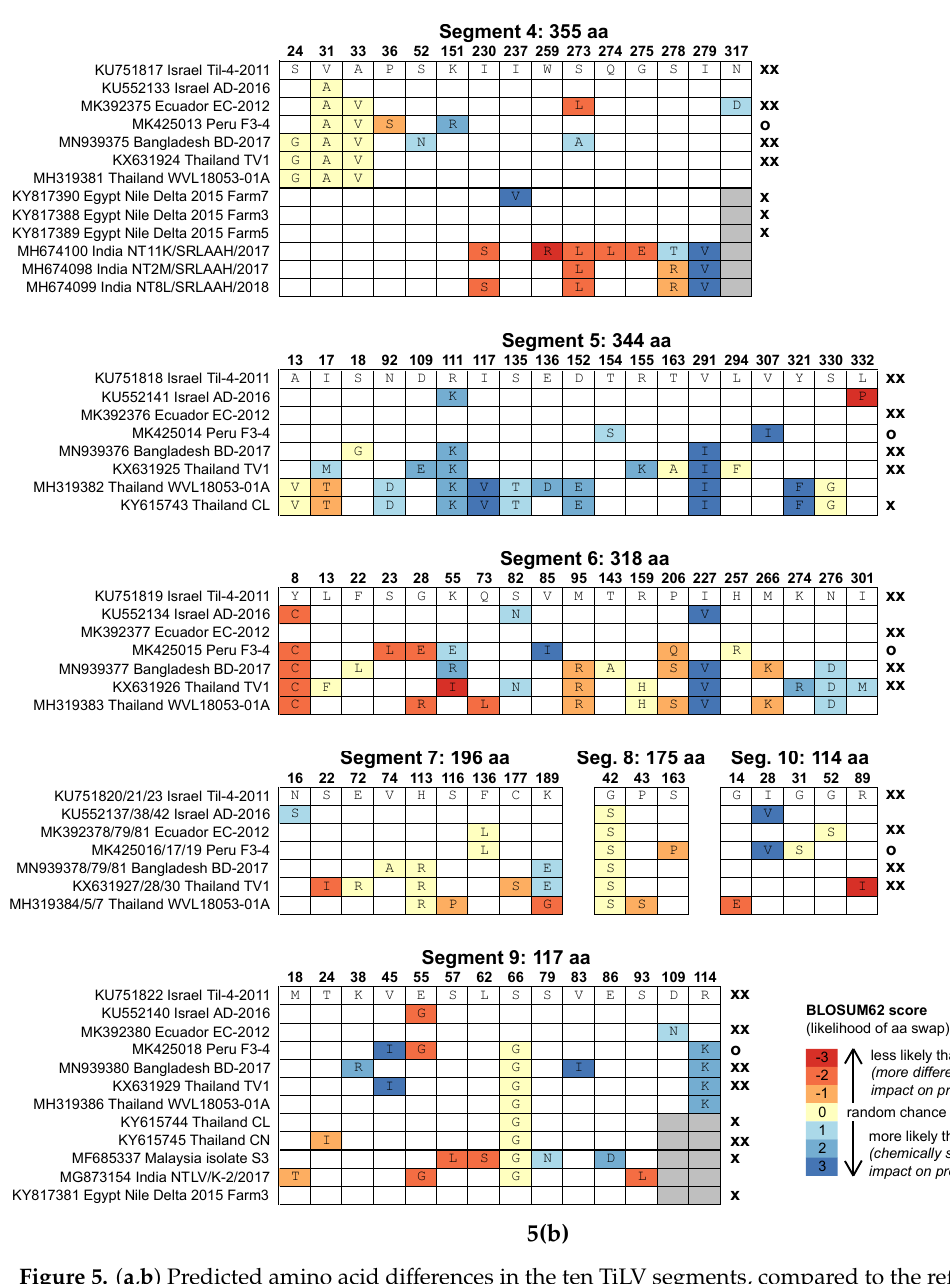
Figure 5. ( a , b ) Predicted amino acid differences in the ten TiLV segments, compared to the reference strain Til-4-2011 from Israel. Numbers along the top show the amino acid position at which there is a difference in at least one sequence, the first line shows the sequence of strain Til-4-2011, and letters in other boxes show where amino acids differ. Colours indicate the BLOSUM62 score, a measure of how frequently the amino acid difference occurs in protein alignments (with blue colours indicating more similar amino acids and red indicating more dissimilar amino acids, with a greater impact on protein structure and function). Grey boxes indicate that the sequence did not extend to that region. Symbols along the right show the severity of outbreak, where reported (xx > 60% mortality, x = 10%–60% mortality, o < 10% mortality or asymptomatic, and no symbol = data not available).